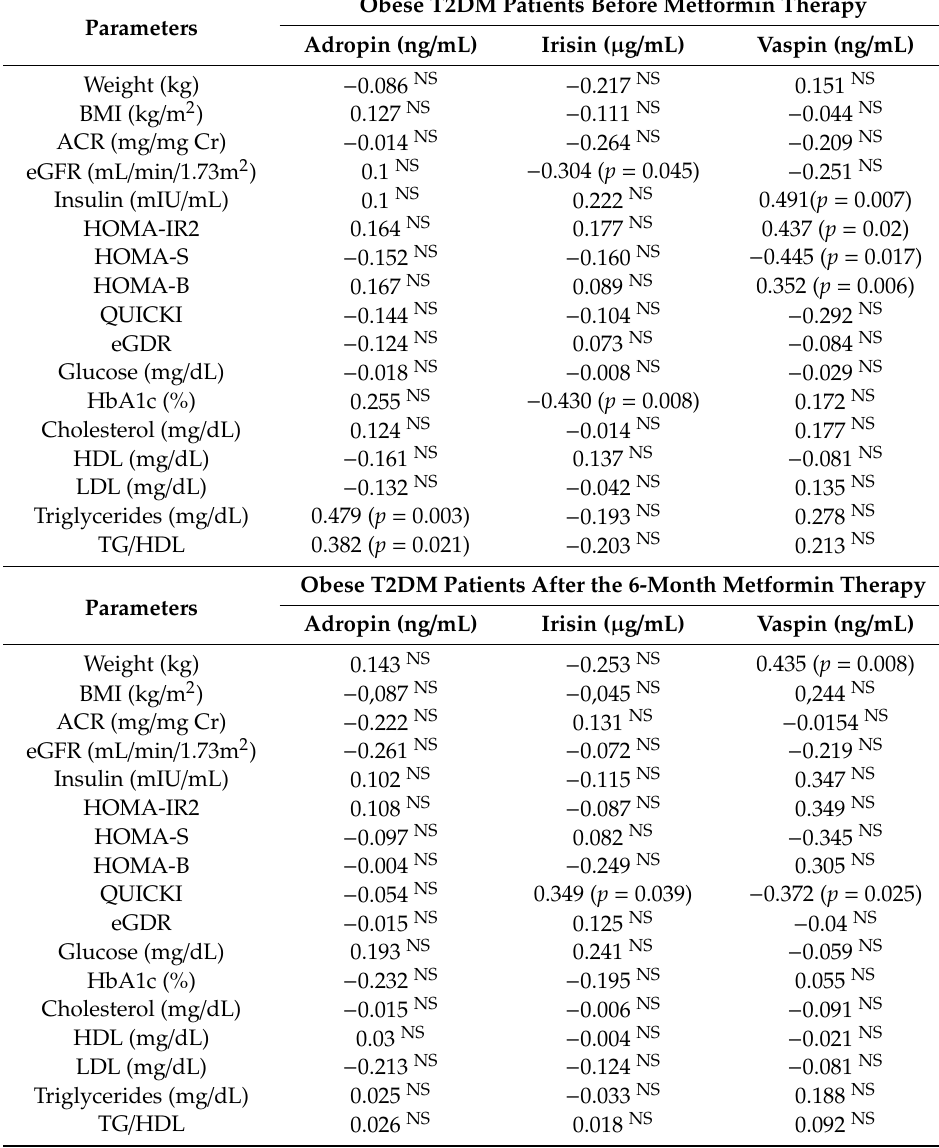
Table 3. Correlation between plasma adipocytokines and anthropometric parameters, renal function indices, insulin resistance indicators and carbohydrate-lipid metabolism parameters in obese patients with type 2 diabetes before implementation of metformin therapy and after a 6-month